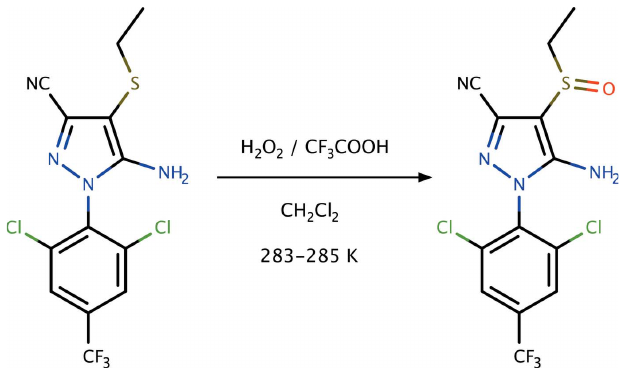
Figure 4 A general reaction scheme for the synthesis of ethiprole.